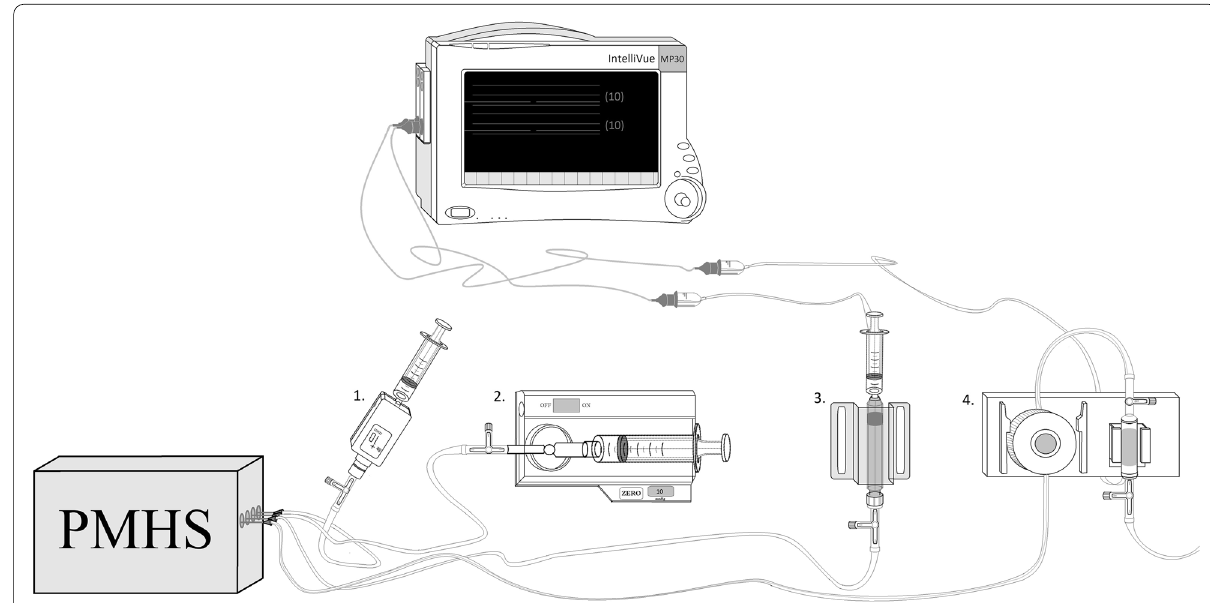
Fig. 1 Schematic representation of the experimental setup. Four different terminal devices were evaluated using the simulation of a compartment syndrome in a post‑mortem human specimen (PMHS): 1. Compass UniversalHg; Iskus Health, Ltd., Dublin, Ireland, 2. Stryker Intracompartmental Pressure Monitor System; Stryker, Kalamazoo, Michigan, 3. Meritrans DTXPlus ® Disposable Transducers; Merit Medical Systems, Jordan, Utah & IntelliVue MX500 monitor; Philips, Eindhoven, the Netherlands, 4. Xtrans ® system; CODAN, Lensahn, Germany & IntelliVue MX500 monitor;